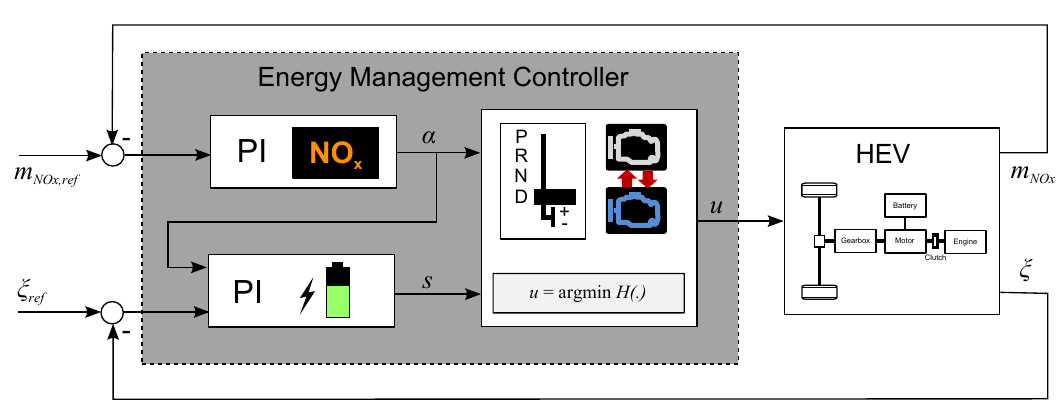
Figure 6. Controller